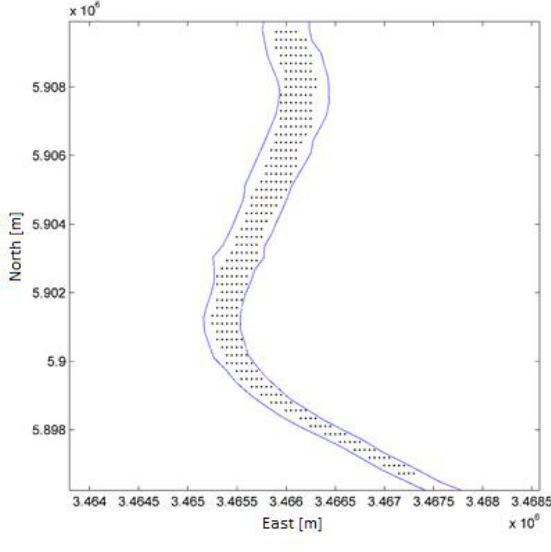
Figure 4: Not-to-scale and slightly skewed illustration of the grid points within the river segment under investigation.